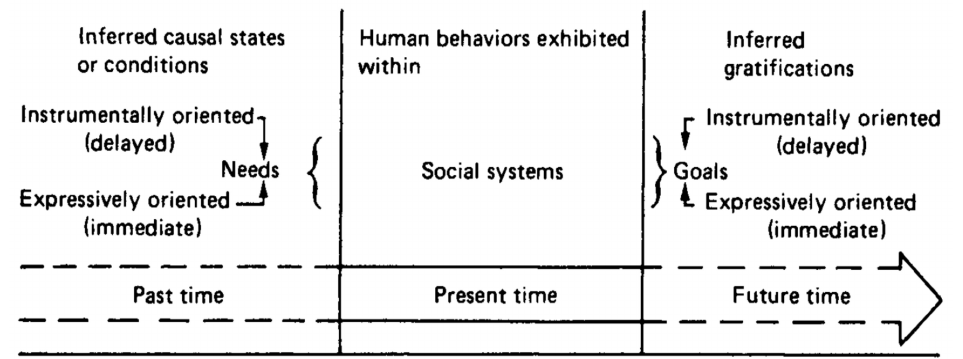
Figure 1. Londoner’s needs → social system → goal gratification model of older adults’ educational participation [22]. Reproduced with permission from Londoner, Carroll A., Sherron, Ronald H., Lumsden, D. Barry, Introduction to Educational Gerontology ; published by Hemisphere Publishing Corporation: London, UK,